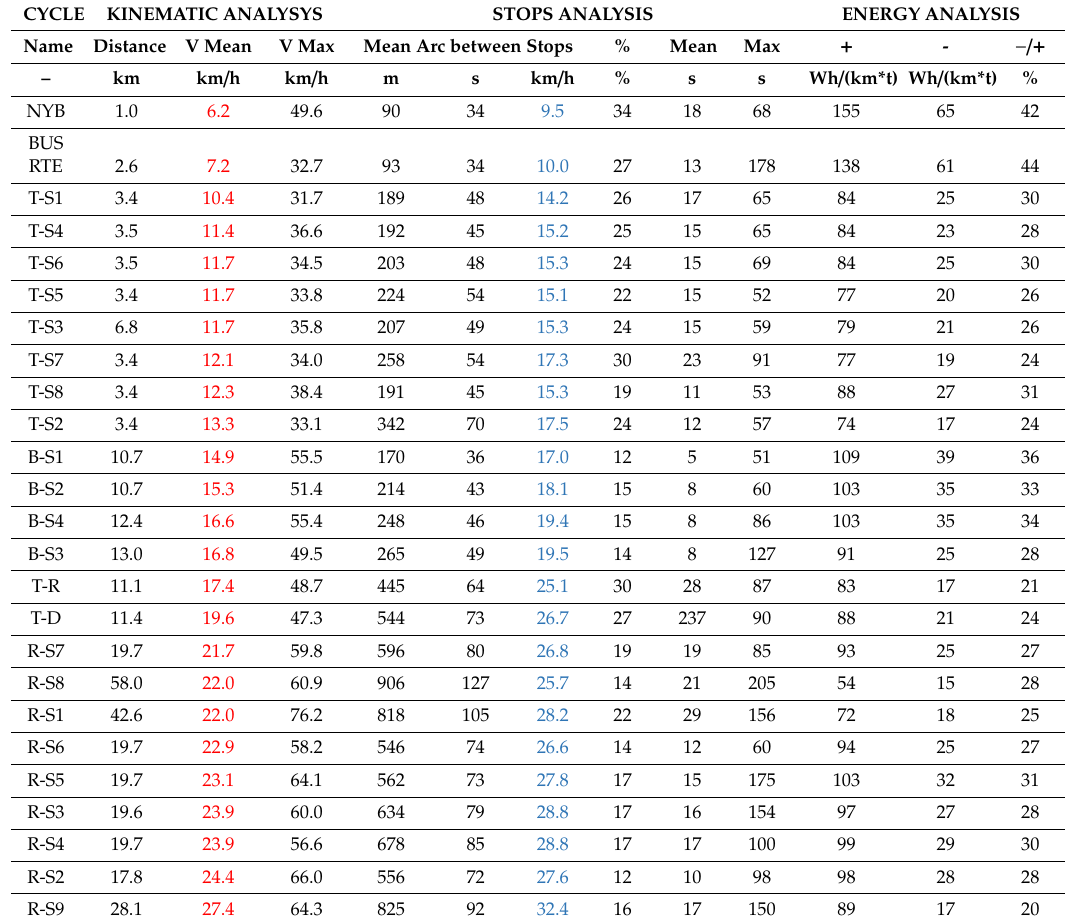
Table 1. Kinematic characteristics of the measured mission